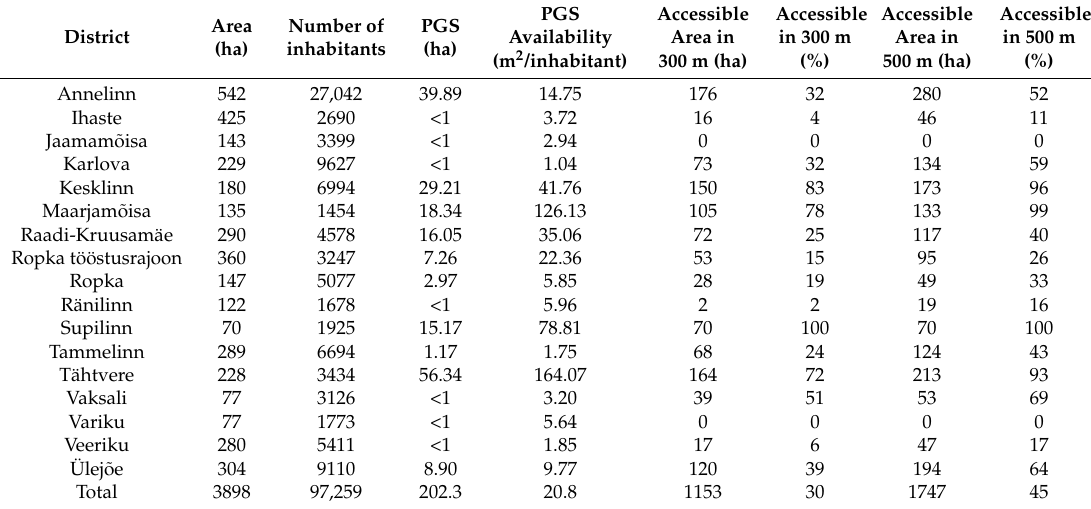
Table 4. Availability and accessibility of public green spaces (PGS) in Tartu.